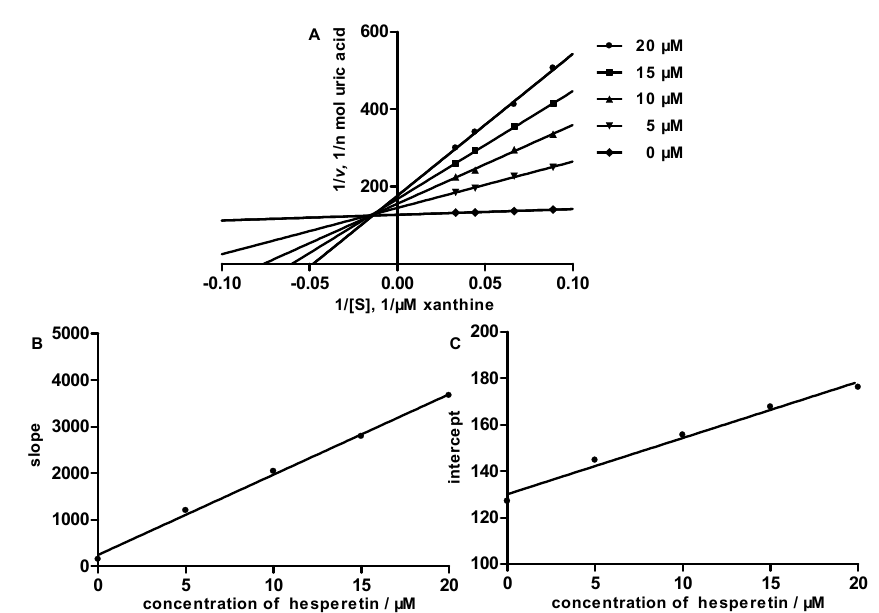
Figure 4. Inhibition kinetics of xanthine oxidase by hesperetin. ( A ) Lineweaver-Burk plots in the absence or at the different concentrations of hesperetin. Each point is the average value from triplicate experiments. Secondary plots to calculate the inhibition constants are shown in ( B ) (K i ) and ( C ) (K I ).